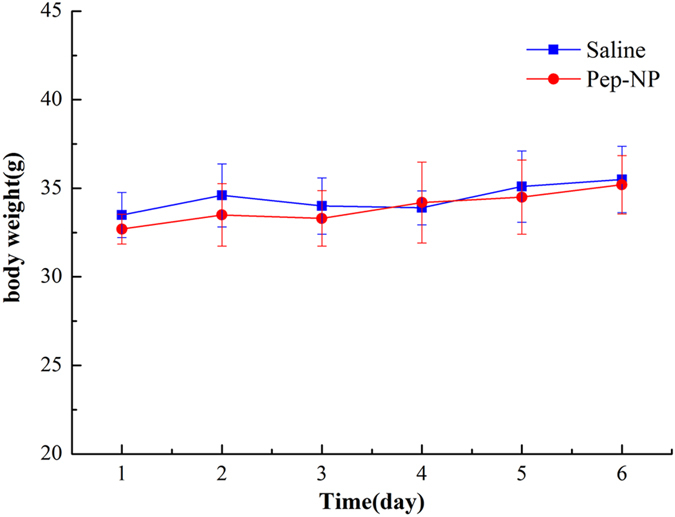
Change in body weight of animals as a function of time in healthy ICR mice.Mice were injected i.v. administration with 100 mg/kg blank Pep-NP or negative control (Saline) for 6 days, one dose per day (n = 5).